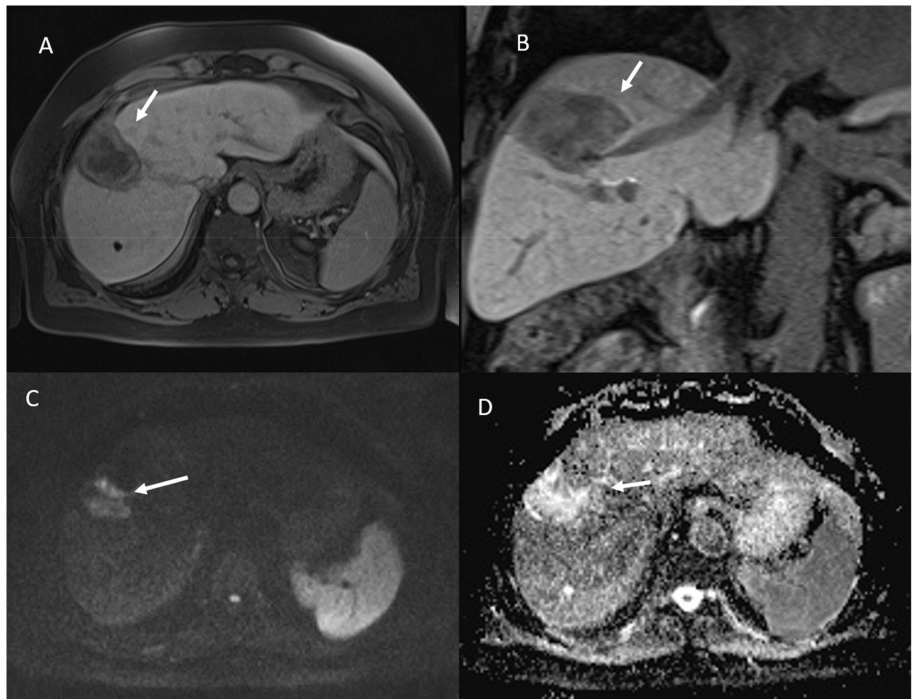
Figure 7. The same patient of Figure 6. Non-viable lesion shows targetoid appearance in the portal ( A ) phase of contrast study and in the hepatospecific phase ( B ), with restricted diffusion in b800 s/mm 2 ( C ) and hyperintense SI in ADC map ( D ).